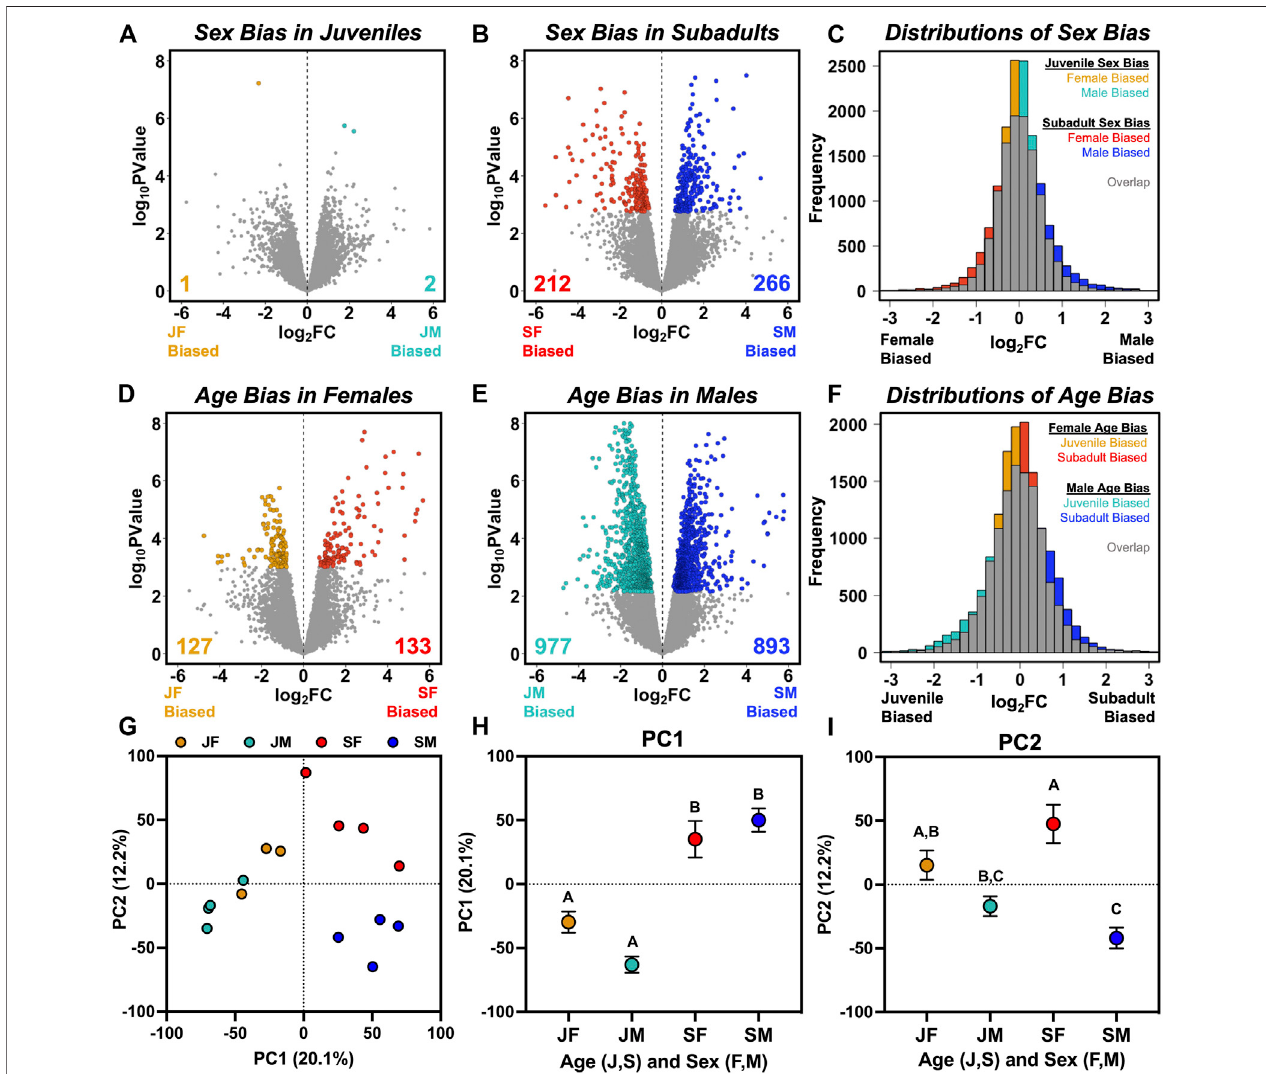
FIGURE 1 | Visualization of sex-and age-biased gene expression based on comparisons of juvenile females (JF), juvenile males (JM), subadult females (SF), and subadult males (SM). (A,B) Volcano plots with colored symbols indicating signi fi cantly (FDR < 0.05) sex-biased genes in (A) juveniles, and (B) subadults, with unbiased genes in gray. (C) Frequency distributions of log 2 fold change (FC) values from (A,B) , with gray indicating overlap between juvenile and subadult distributions and colors indicating an excess of low sex bias in juveniles and high sex bias in subadults. (D,E) Volcano plots with colored symbols indicating signi fi cantly (FDR < 0.05) age- biased genes in (D) females, and (E) males, with unbiased genes in gray. (F) Frequency distributions of log 2 (FC) values from (D,E) , with gray indicating overlap between female and male distributions and colors indicating an excess of low age bias in females and high age bias in males. (G) Separation of individuals along the fi rst two principal components describing variation in transcriptome-wide expression, alongside the mean (±SE) values for (H) PC1, and (I) PC2 for each group. Letters above each symbol indicate post-hoc separation based on analysis of variance.